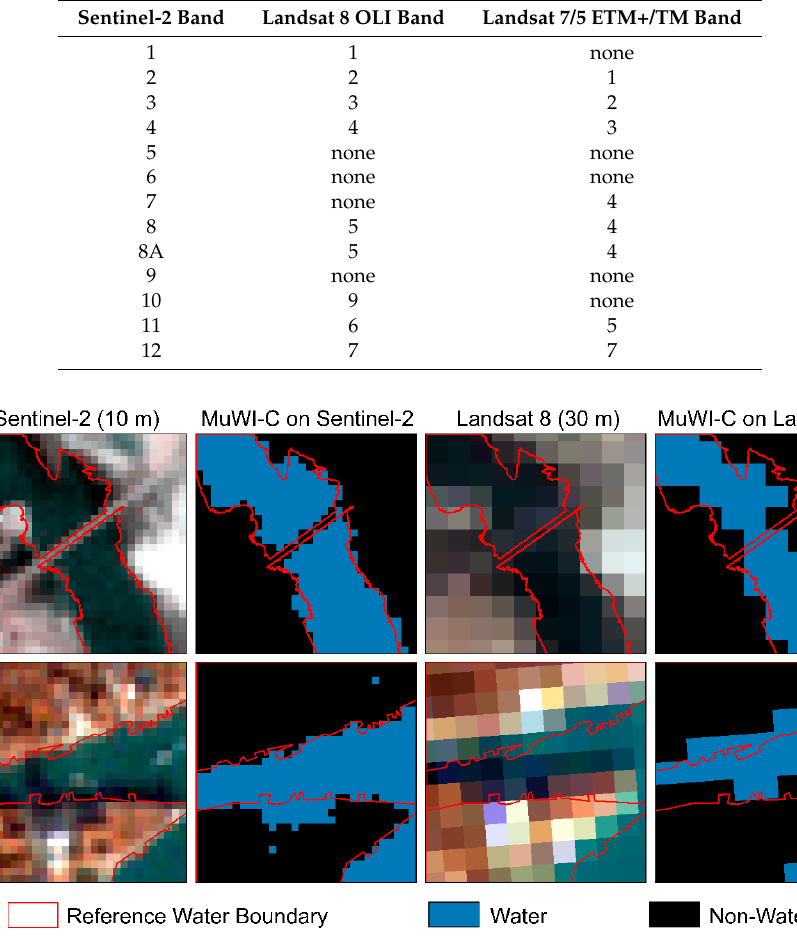
Figure 7. Visual comparisons of MuWI applications on Sentinel-2 and Landsat 8. Two rows indicate two 300 m × 300 m reference sites that are the same as in Figures 4 and 5. Four columns represent (from left to right): Sentinel-2 MSI RGB (4, 3, 2) 10 m natural color image, MuWI-C classified result on Sentinel-2, Landsat 8 OLI RGB(4, 3, 2) 30 m natural color image, and MuWI-C classified result on Landsat 8.